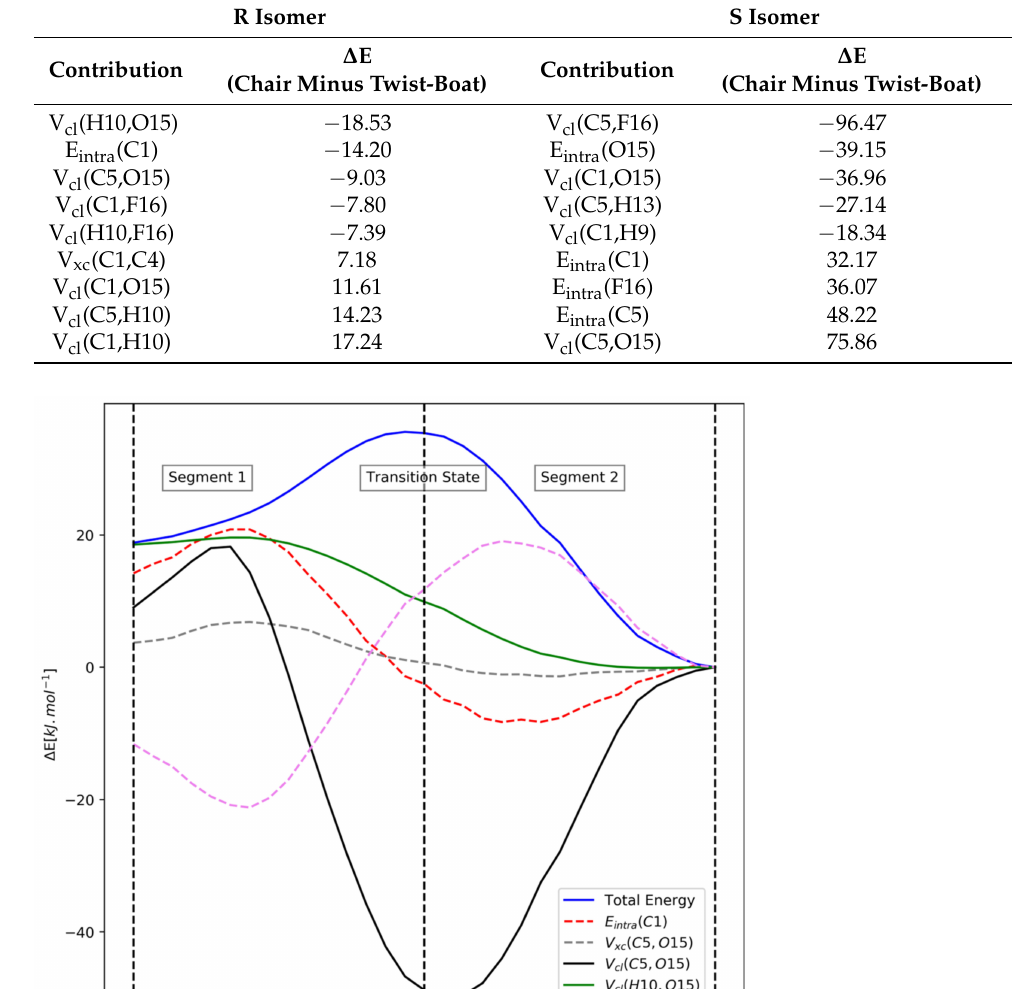
Table 6. A few of the largest-magnitude IQA energy differences (kJ · mol − 1 ) for the R and S isomers.